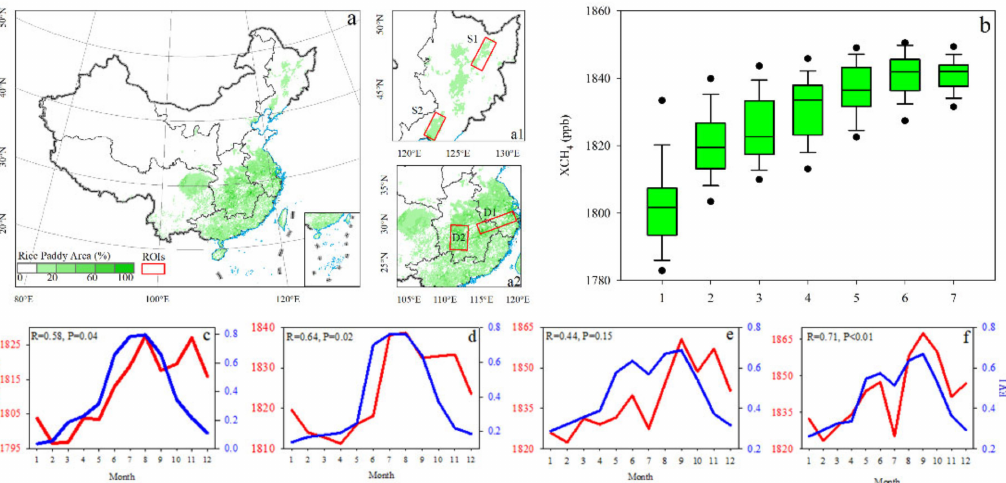
Figure 8. Relationship between rice paddies and XCH 4 concentrations. ( a ) Spatial distribution of rice paddy areas in China and the four regions of interest (ROIS); ( a1 ) Single cropping rice S1 and S2; ( a2 ) Double cropping of rice D1 and D2; ( b ) XCH 4 concentrations at seven areas with different proportions of rice paddies (1–7 correspond to <0.5%, 0.5–1%, 1–5%, 5–10%, 10–20%, 20–40%, and >40%, respectively); ( c – f ) The monthly average of XCH 4 concentrations and enhanced vegetation index (EVI) on rice paddy pixels (rice area >10%) in four regions of interest (ROIs) of S1, S2, D1, and D2,